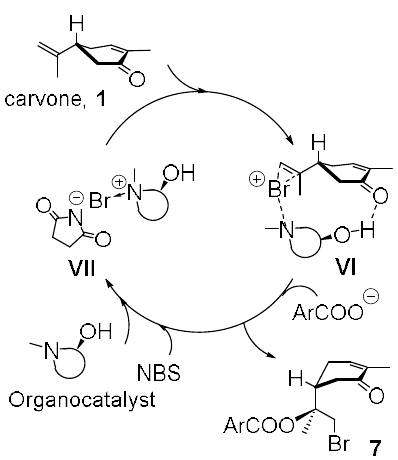
Figure 4. Proposed mechanism for the observed stereochemical outcome.